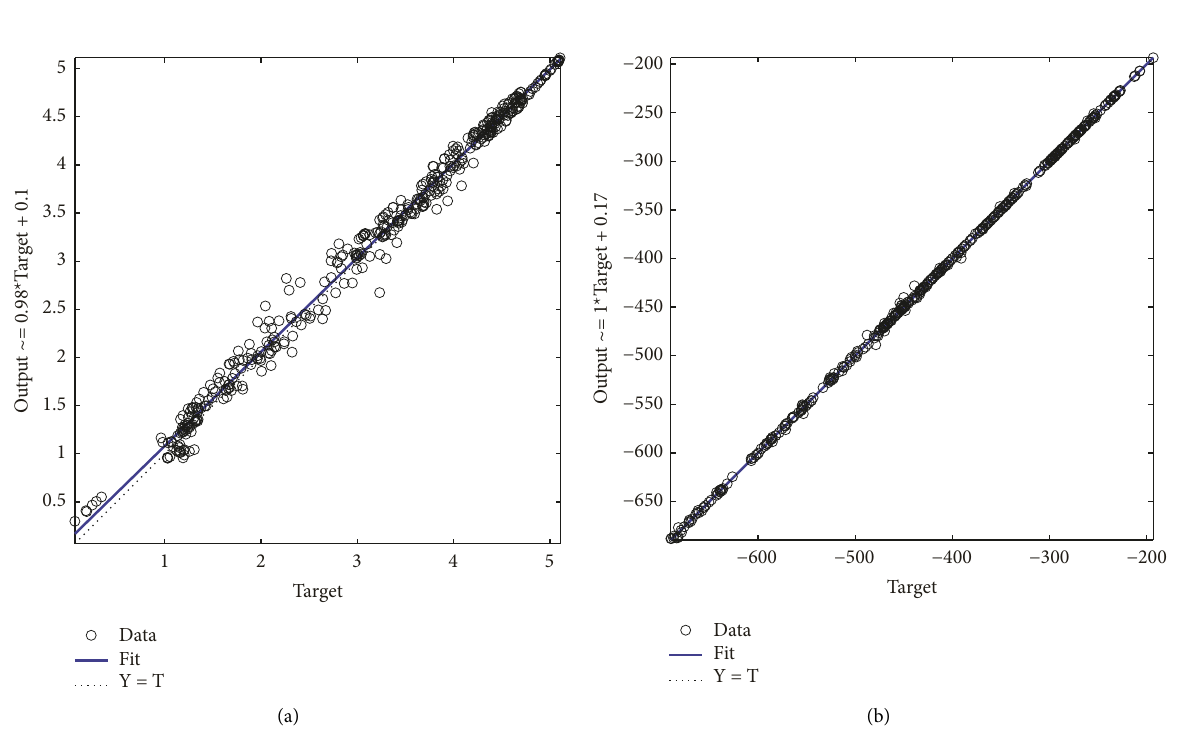
Figure 15: Similarity between target and predicted output. (a) R � 0.9955 for Q